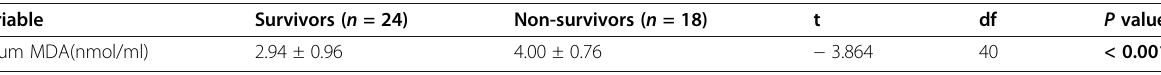
Table 3 Relation between MDA and survival Variable Data are mean ± SD t T statistic, df Degree of